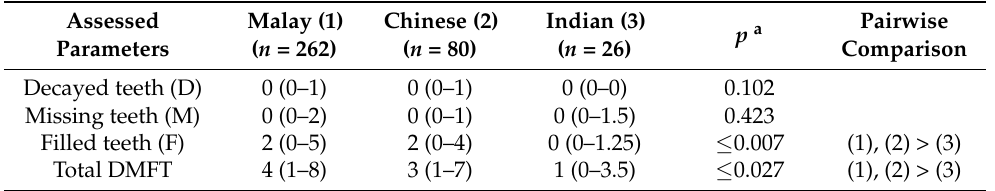
Table 3. Comparison of decayed, missing, filled teeth, and total DMFT [median (interquartile range)] between ethnic groups ( n = 368).